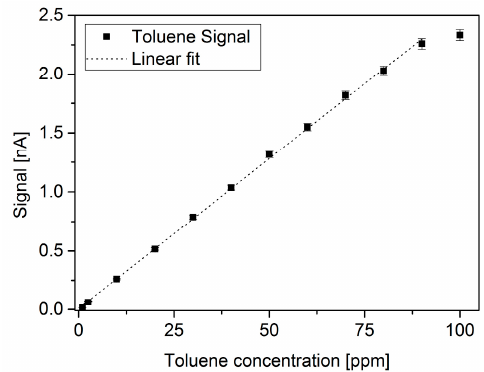
Figure 10. Channel 3 signal at 1–100 ppm toluene range. 20 mL/min and 30 V applied. Relative error is 2% for all data points.